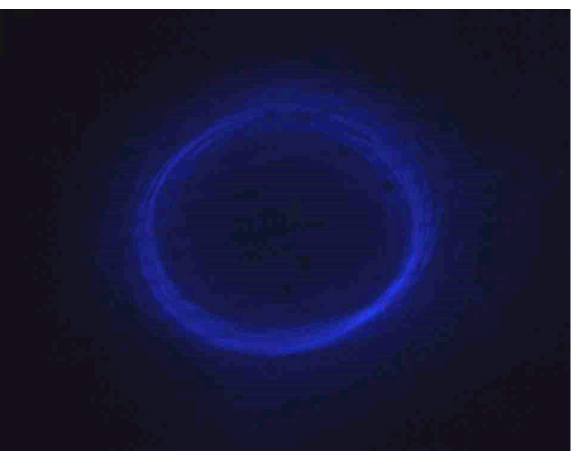
Figure 25. Front view of cantilever scan for vibration at its resonant frequency.